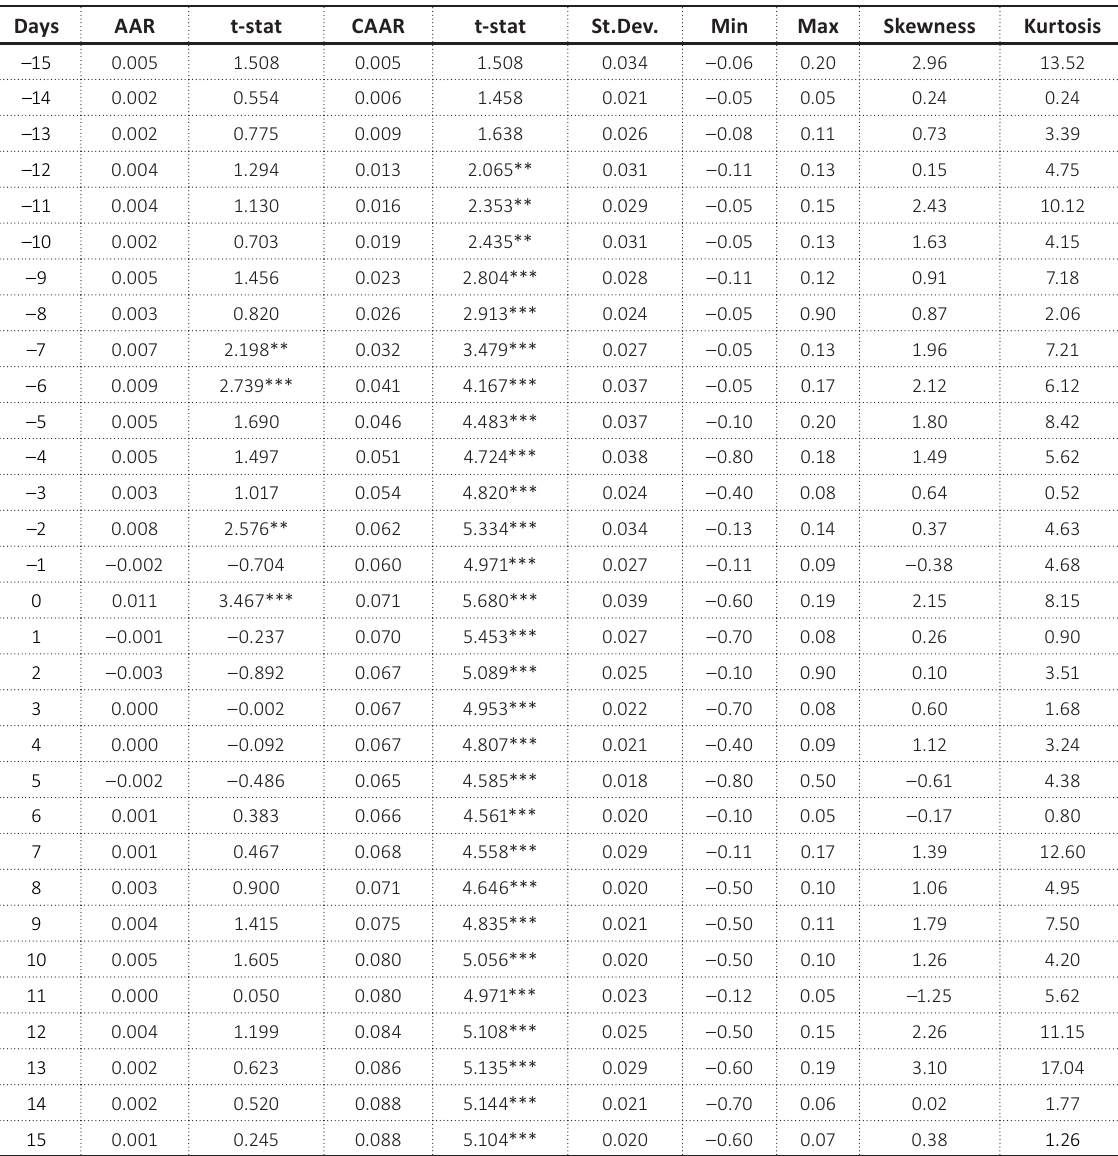
Table 2. AAR and CAAR values of all